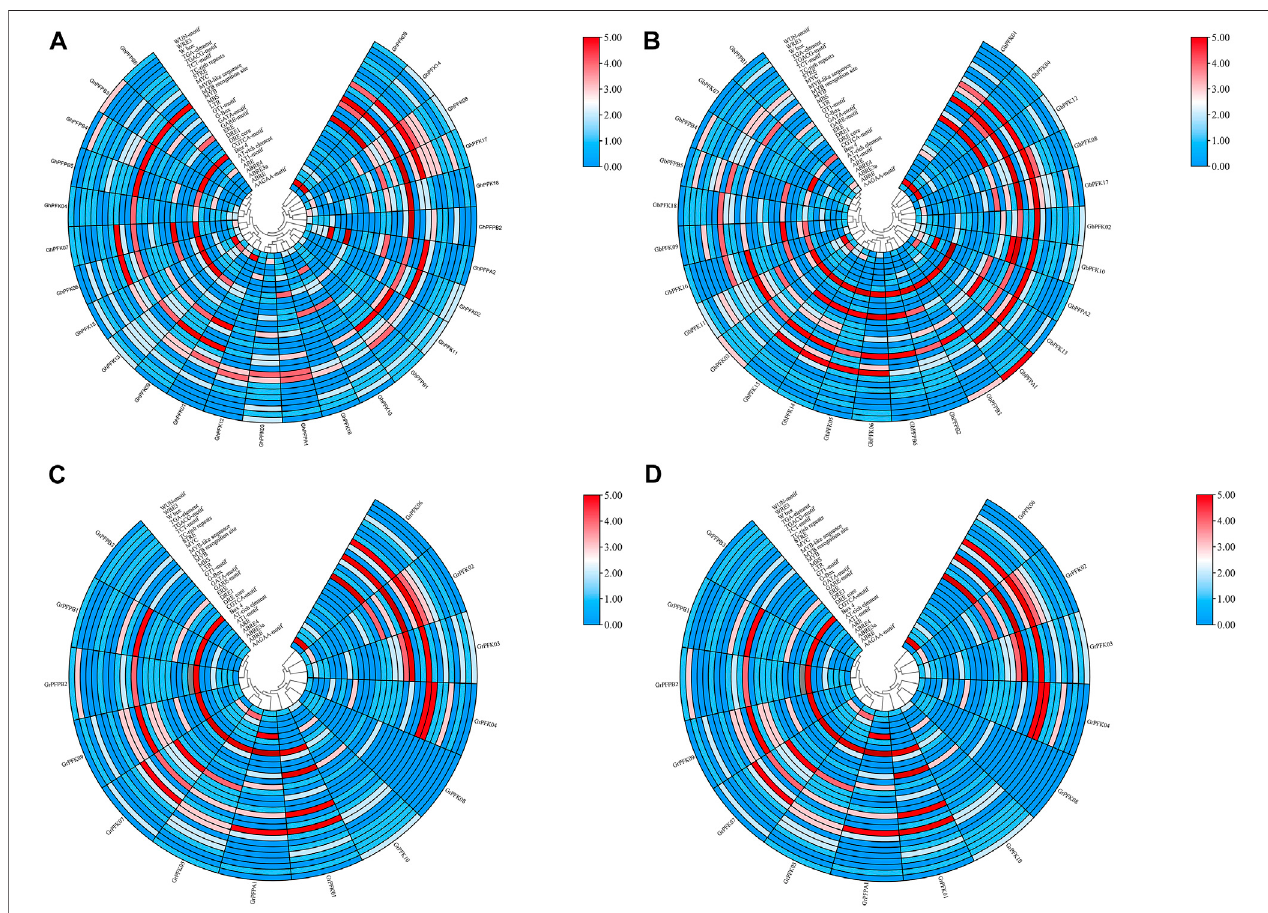
FIGURE 6 | Cis-regulatory elements analysis of the PFK gene family. (A) G. hirsutum; (B) G. barbadense; (C) G. arboreum; (D) G. raimondii